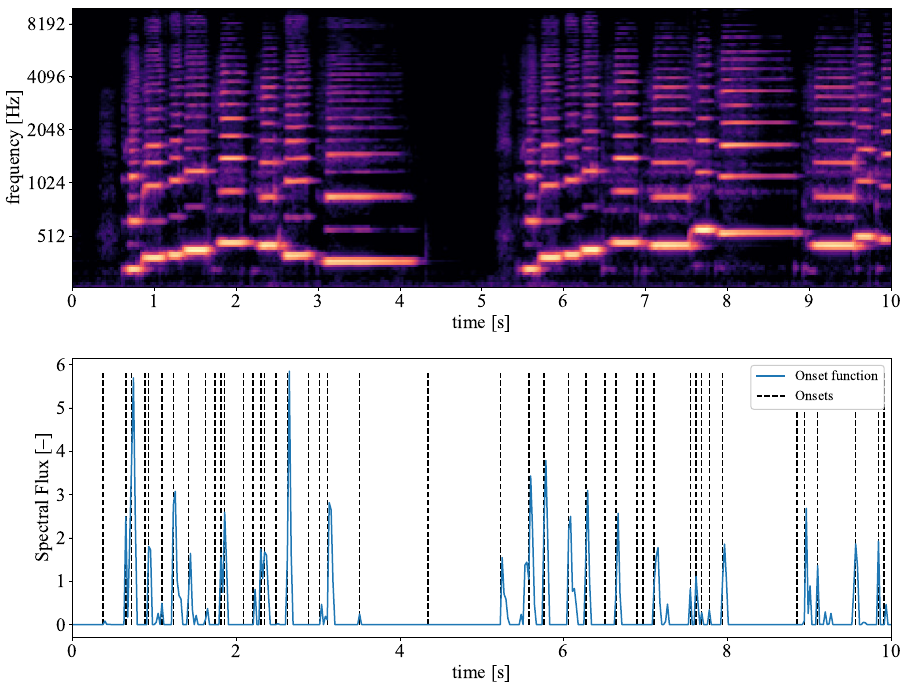
Figure 3. Spectrogram and onset detection function for a solo clarinet without the TKEO.